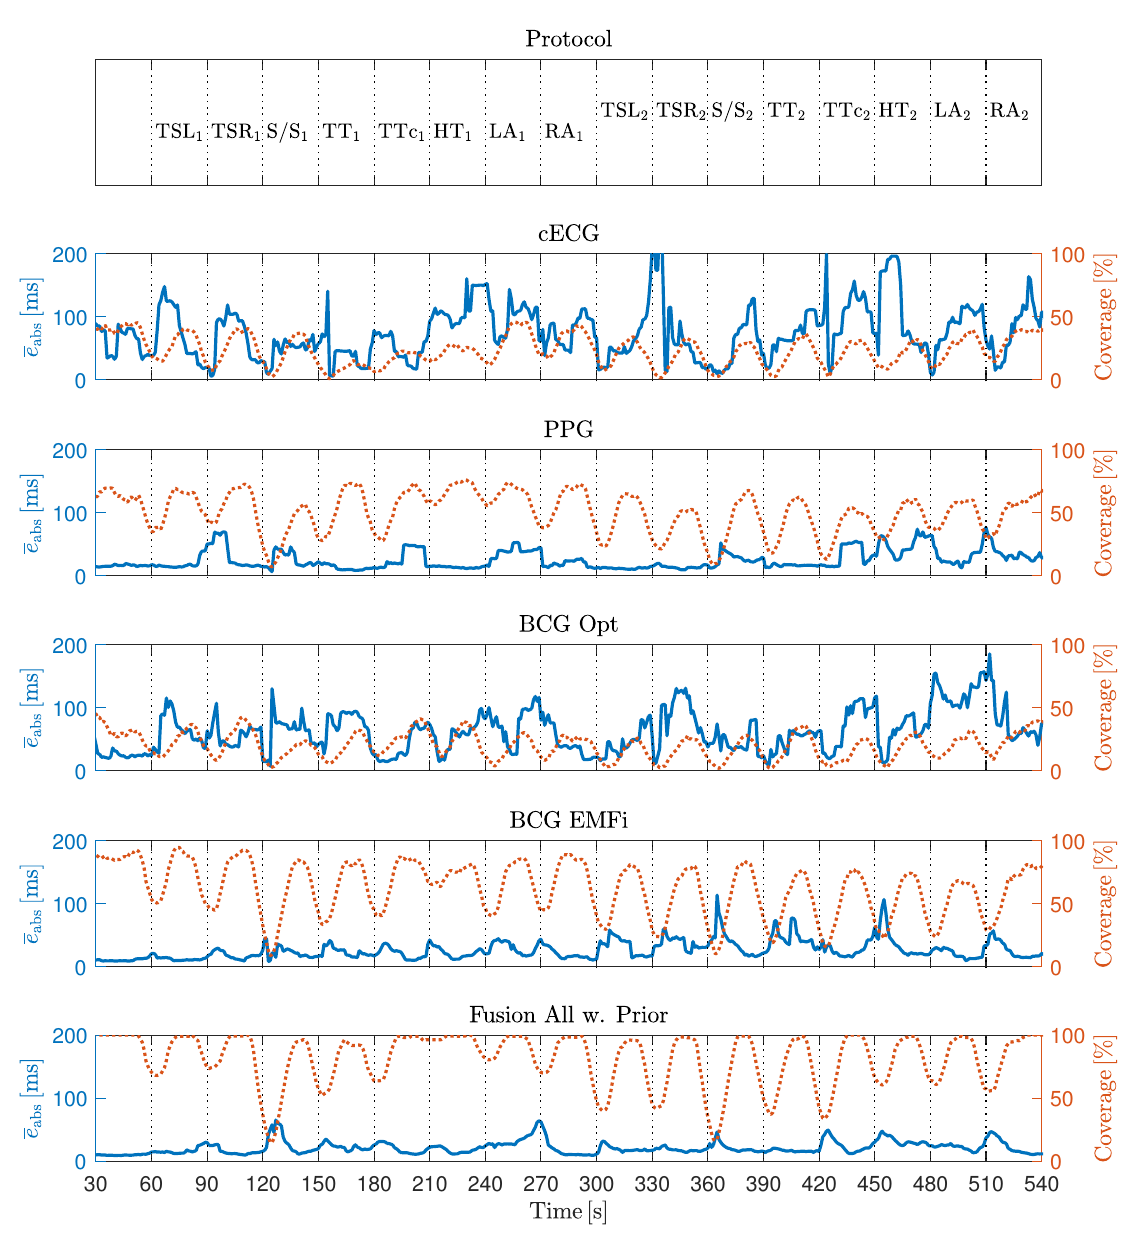
Figure 11. Mean absolute estimation error and coverage, averaged over all subjects in a moving window of 12 s duration. Troughs in the coverage can be observed for all sensors when the motion protocol is